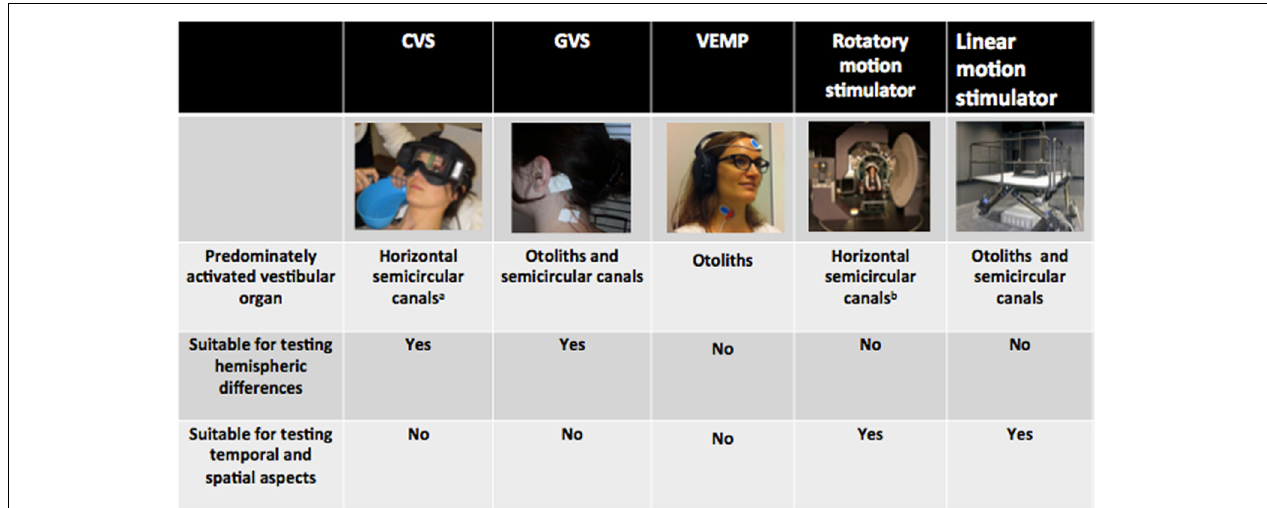
subject position on a custom-built rotatory chair with the subject placed such that their center of head rotation falls along the chair rotation axis. This type of rotation predominantly activates the horizontal semicircular canals. Note that the vertical semicircular canals and the otoliths can also be activated by displacing the subject’s head out of the chair rotation axis (i.e., lateral displacement or